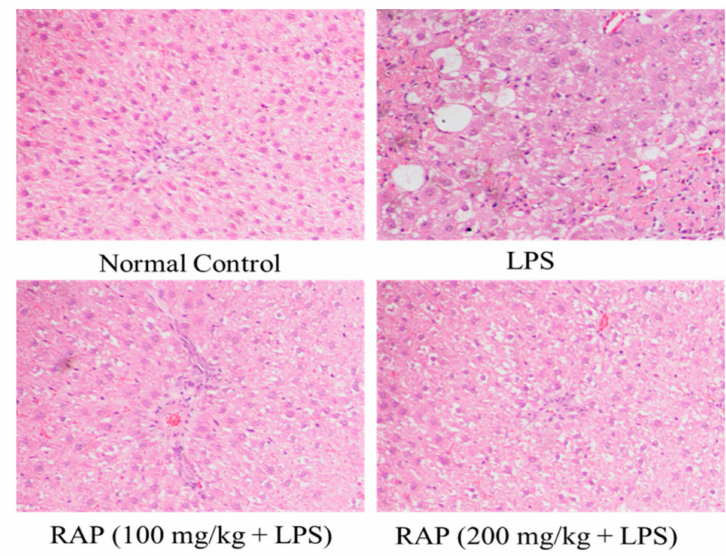
Figure 6. E ff ect of RAP (100 and 200 mg / kg) on histological alterations in the liver of LPS-induced systemic inflammation. Normal control rats showing intact hepatocytes and normal histological structure of central vein. LPS treated rats showing multiple focal necrosis, severe damage of hepatic architecture, and damage in hepatocytes. Rats treated with RAP 100 mg / kg + LPS and RAP 200 mg / kg + LPS showing absence of histopatholgical alterations.